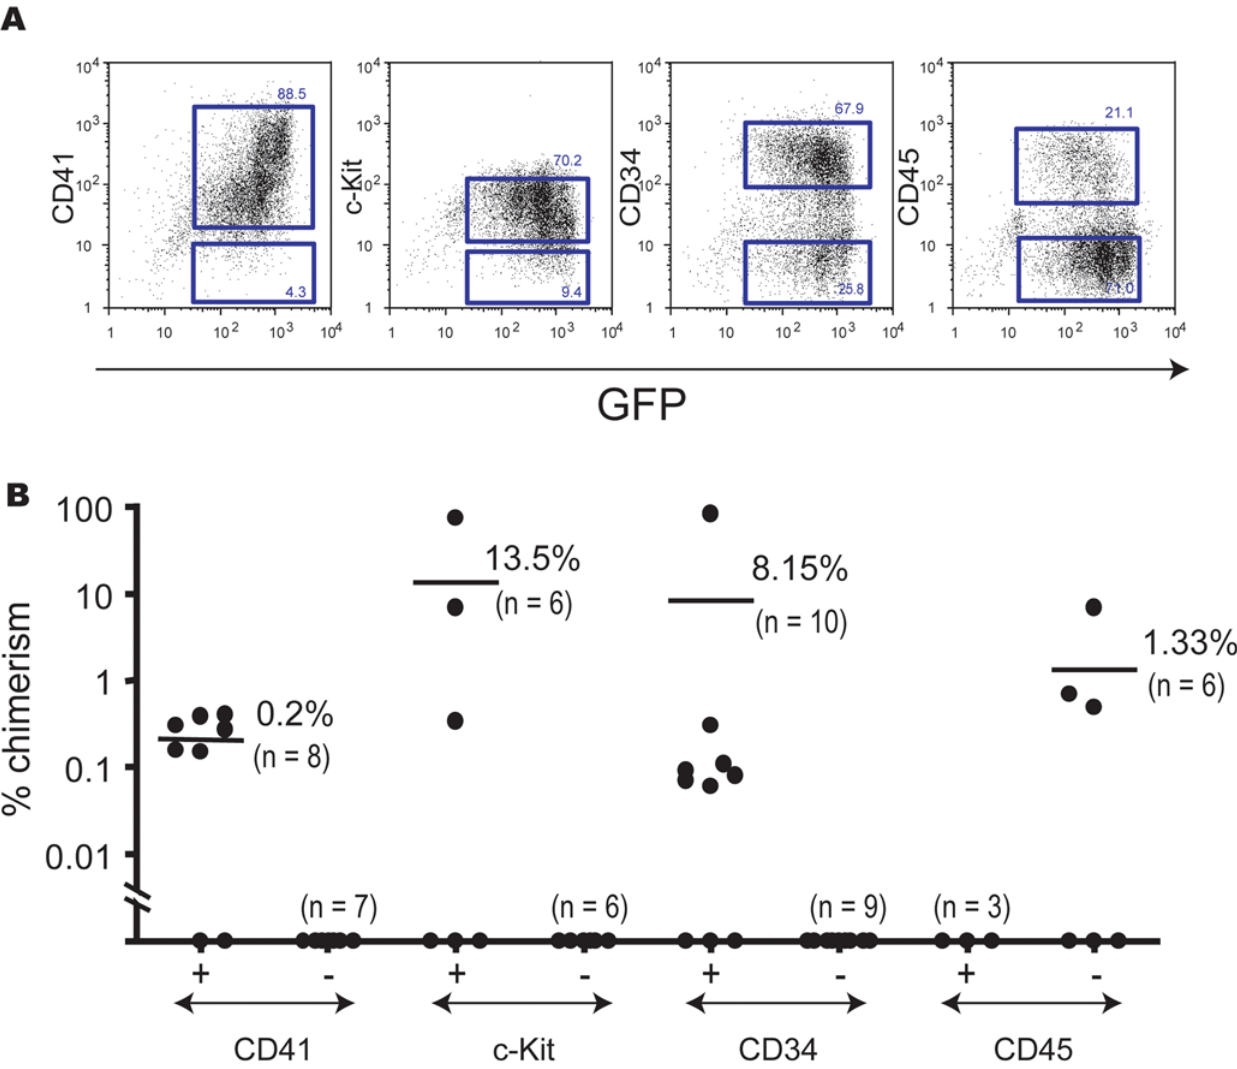
Figure 4. Surface markers of embryonic HSCs generated from EB6 cells invitro . (A) CD41 + EB6 cells were co-cultured with OP9 cells in the absence of Dox for 4 days. Cells collected from the co-cultures were analyzed by flow cytometry. HOXB4-expressing cells were detected by GFP expression. Data show the expression of CD41, c-Kit, CD34, and CD45 in GFP + cells. The sorting gates for CD41 2 or CD41 + cells, c-Kit 2 or c-Kit + cells, CD34 2 or CD34 + cells, and CD45 2 or CD45 + cells are shown as squares. (B) Co-cultured cells were fractionated based on expression of CD41, c-Kit, CD34, and CD45, and were transplanted into lethally irradiated mice. Recipient mice were analyzed 16 weeks after transplantation. Over 95% of reconstituted blood cells were of myeloid lineage in all cases (data not shown). Two independent experiments gave similar results. Data from one experiment are shown. See Table S2 for the number of transplanted cells for each subpopulation.